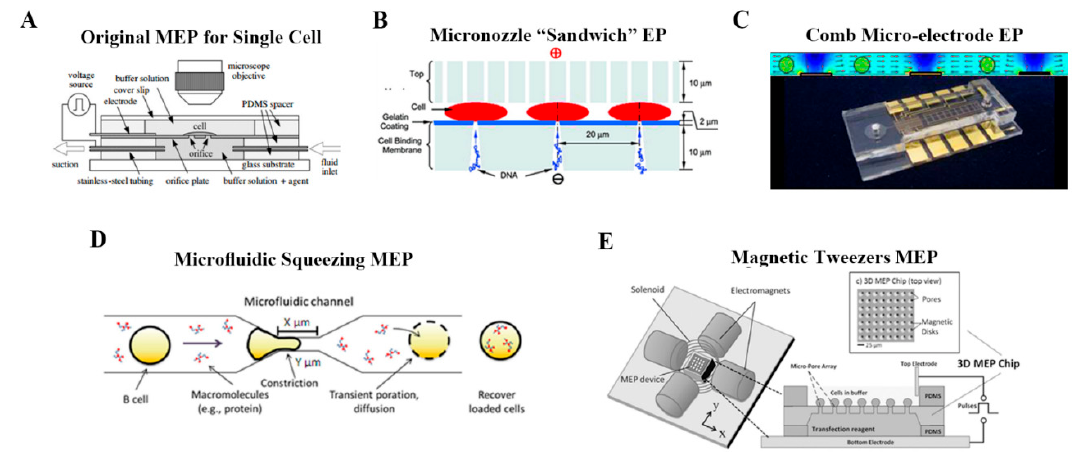
Figure 6. Representative schematics of micro-scale cargo delivery systems. ( A ) Electroporation through a micro-fabricated orifice to the measurement of single cell response to external stimuli. Reprinted with permission from ref. [50]. ( B ) High-throughput micronozzle-based sandwich EP system. Reprinted